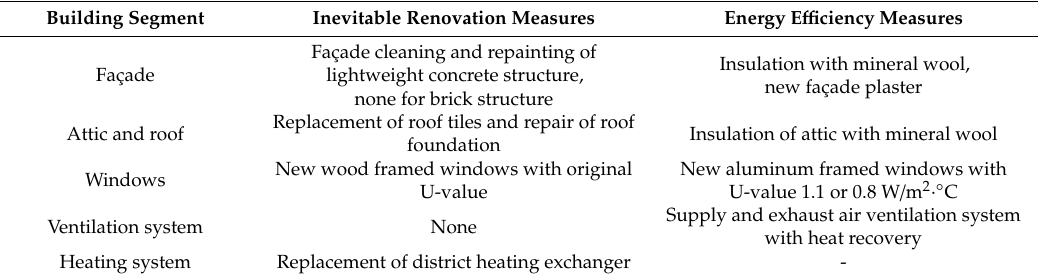
Table 7. Inevitable renovation measures and energy e ffi ciency measures (EEMs) of the di ff erent building segments.